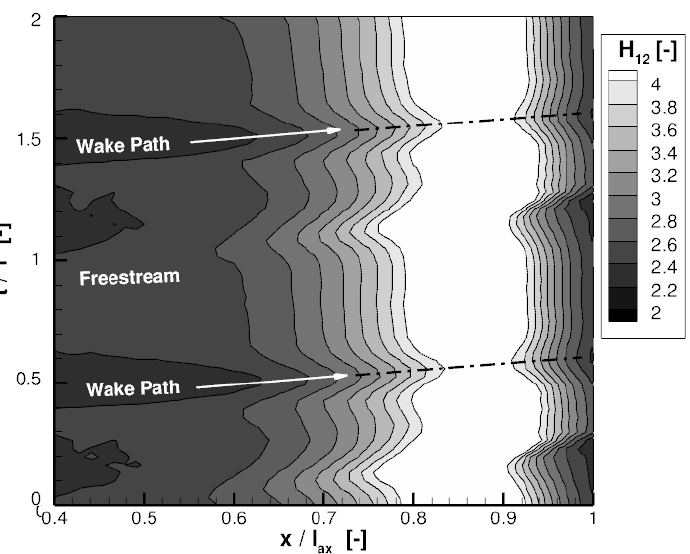
Figure 7. Space-Time diagram of shape factor H 12 predicted by the HB method based on Lanczos- filtered